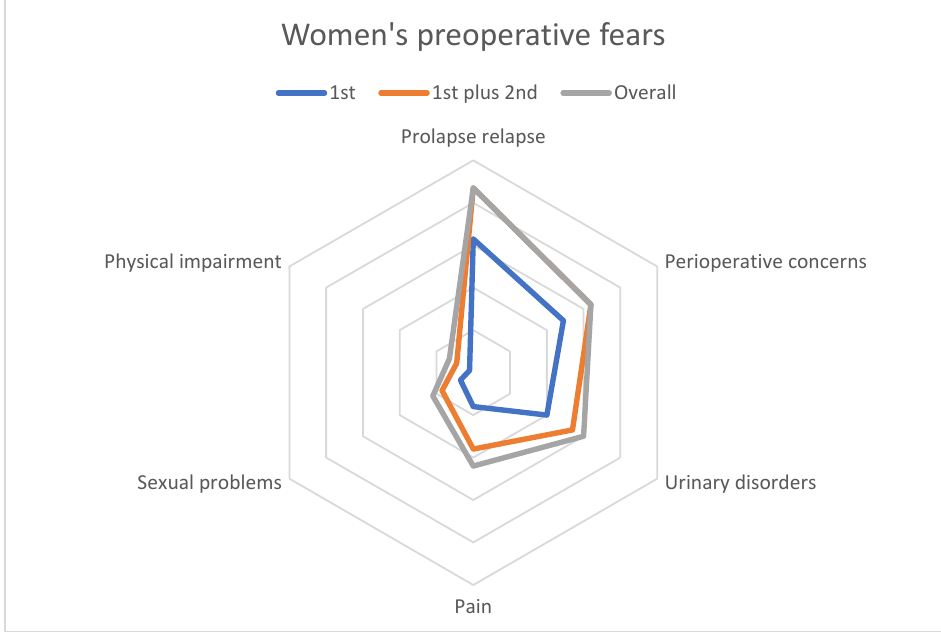
about the perioperative period (21%), and urinary disorders (17%) (see Table 4 and Figure 4). The leading fears ranked second were again prolapse relapse (23%) and the perioper- ative period (17%), as well as pain (17%).